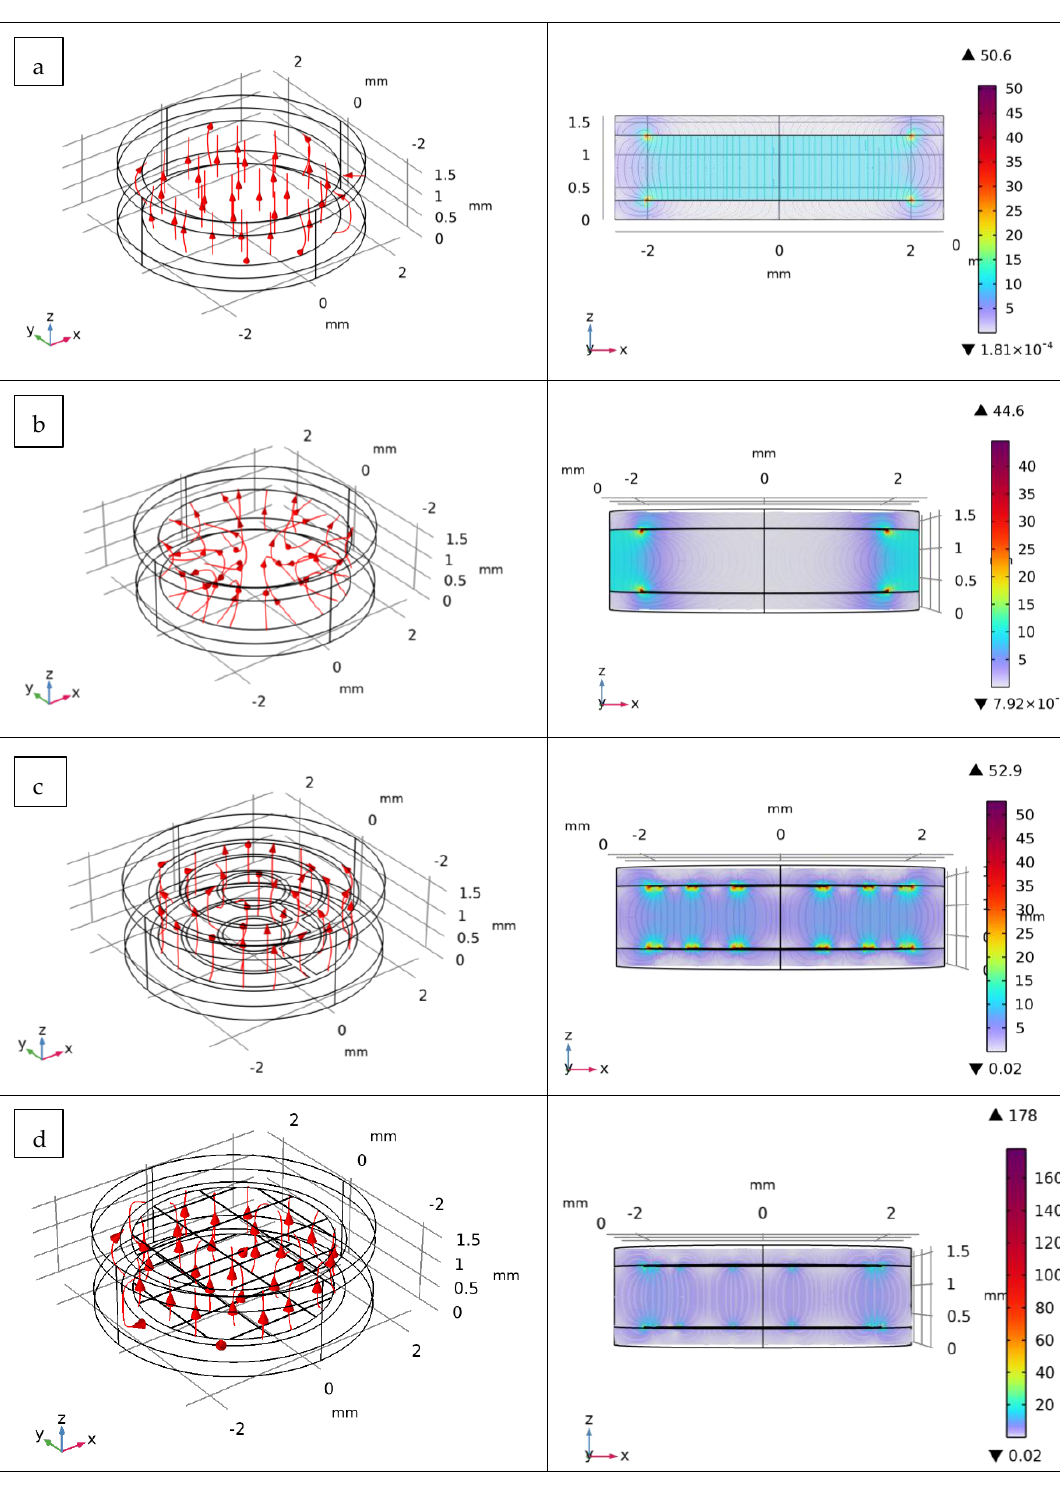
Figure 6. Simulation by COMSOL Multiphysics ® of the behavior of electric field (in V/m) inside the cell-culture chamber using the different design of impedance sensors: ( a ) planar disk-electrodes, ( b ) ring-electrodes, ( c ) multi-ring-electrodes and ( d ) grid-electrodes. The focus regarding the electric field lines in the 2D representation (section view, xz plan) is set at the middle of the chamber.